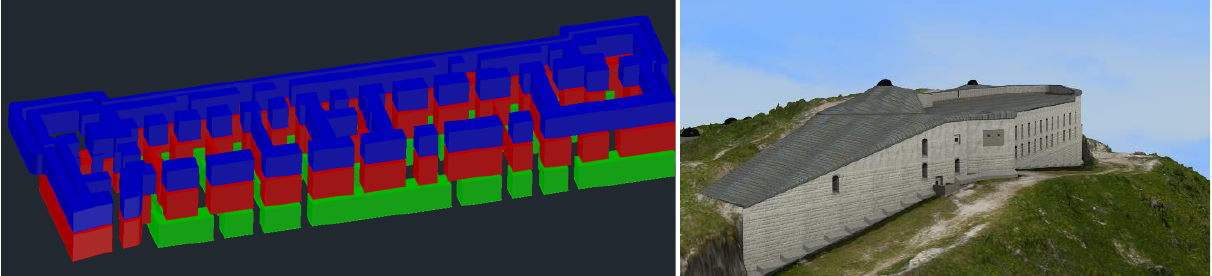
Figure 5. Modelling of forts and example of the produced 3D models inserted into their digital environment.